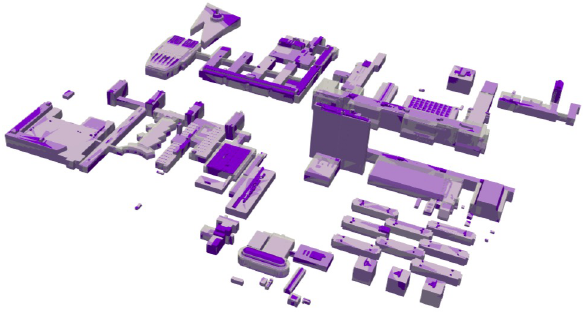
Figure 1. LoD1.3 (grey with transparency) and LoD2.2 (purple) geometry